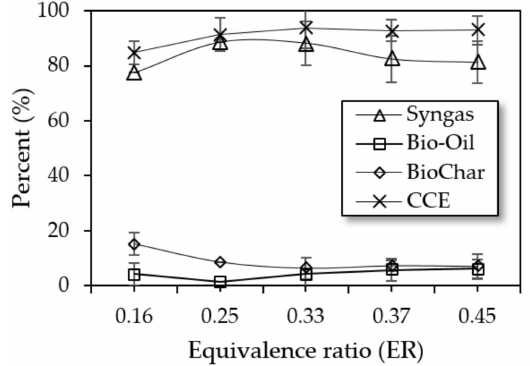
Figure 11. The e ff ect of ER on gasification performance and e ffi